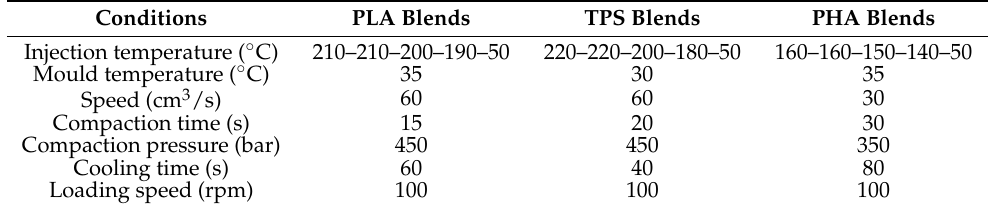
Table 1. Injection moulding conditions of binary blends.